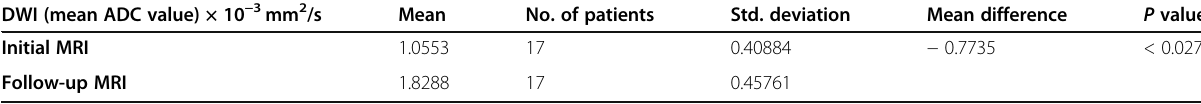
Table 2 Analysis of mean ADC values in good response